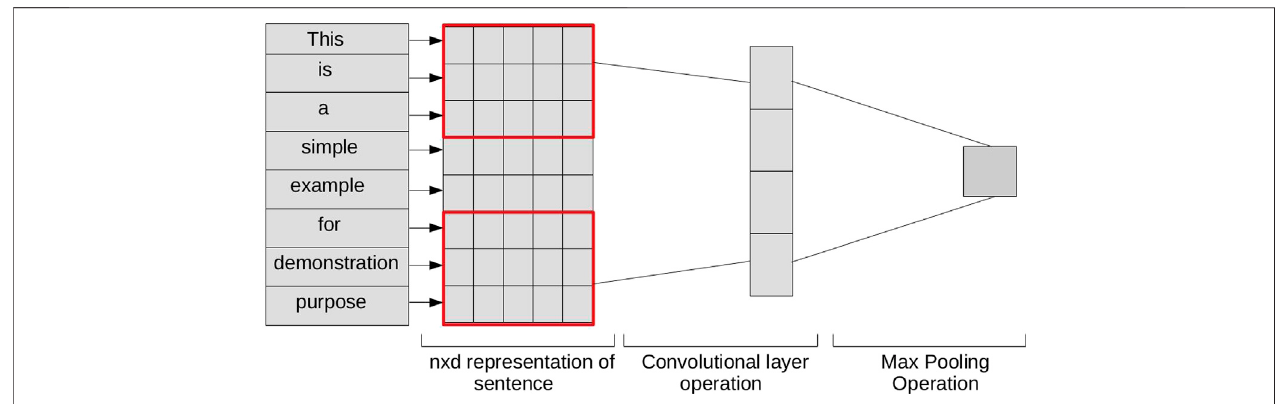
FIGURE 1 | Demonstration of CNN over text for an example